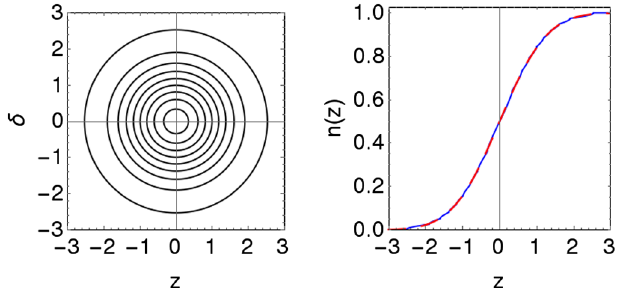
FIG. 3. Longitudinal phase space distribution of the nested airbag beam (left) and the corresponding normalized integrated charge density (right): the blue line depicts the integrated density ¼ 9 airbags, the dashed red — for a Gaussian for n r